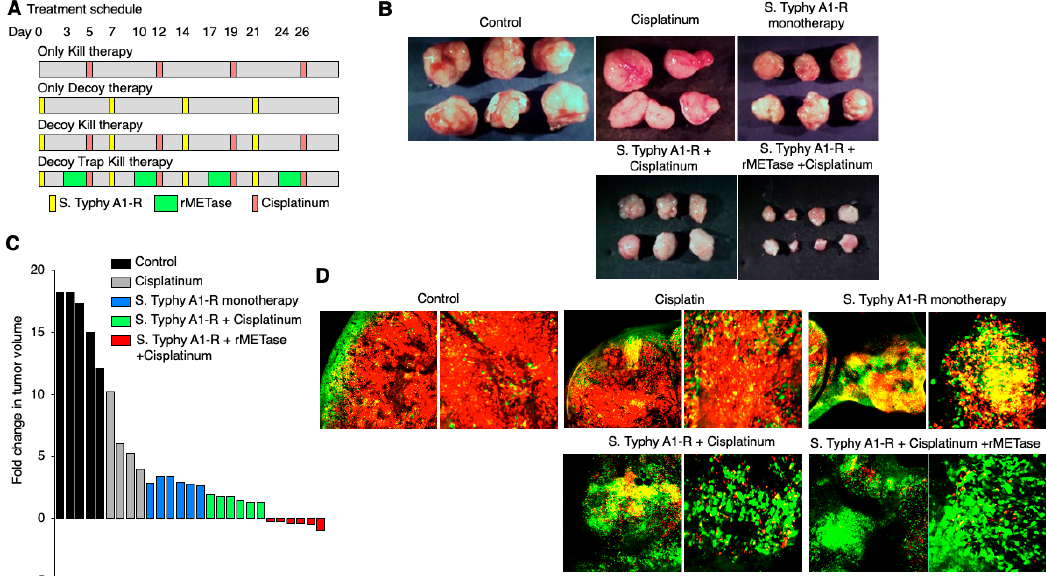
Figure 10. Decoy, trap, and kill chemotherapy with FUCCI imaging. FUCCI ‐ expressing MKN45 stomach cancer cells (5 × 10 6 cells/mouse) were injected subcutaneously into the left flank of nude mouse. When the tumors reached approximately 8 mm in diameter (tumor volume, 300 mm 3 ), mice were administered iv S. typhimurium A1 ‐ R alone or with cisplatinum (CDDP; 5 mg/kg ip) for 5 cycles every 7 days, in combination with S. typhimurium A1 ‐ R and CDDP or in combination with S. typhimurium A1 ‐ R, recombinant methioninase (rMETase; dose ip 200 u/day 3 days/cycle), and CDDP (5 mg/kg, ip). ( A ) Treatment schedule. ( B ) Macroscopic photographs of FUCCI ‐ expressing MKN45 subcutaneous tumors, untreated control: S. typhimurium A1 ‐ R ‐ treated, CDDP ‐ treated, or treated with the combination of S. typhimurium A1 ‐ R and CDDP or the combination of S. typhimurium A1 ‐ R, rMETase, and CDDP. ( C ) Waterfall plot indicating fold change in tumor volume with each treatment. ( D ) Representative images of cross ‐ sections of FUCCI ‐ expressing MKN45 subcutaneous tumors, untreated control: S. typhimurium A1 ‐ R ‐ treated, CDDP ‐ treated, or treated with the combination of S. typhimurium A1 ‐ R and CDDP or the combination of S. typhimurium A1 ‐ R, rMETase, and CDDP [45]. iv = intravenous; ip = intraperitoneal. Scale bar; 500 μ m.